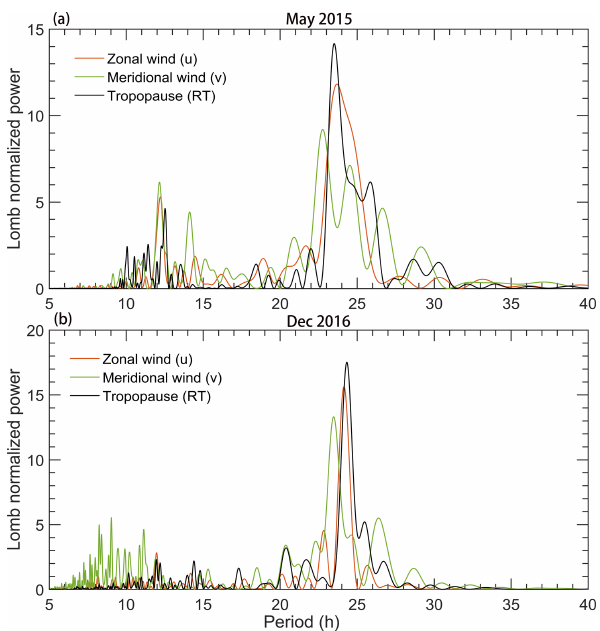
Figure 10. Lomb–Scargle periodograms of the RT height and zonal and meridional wind oscillations for specific months of (a) May 2015 and (b) December 2016. The zonal and meridional wind for (a) is sampled at 9.85km and (b) at 11km.